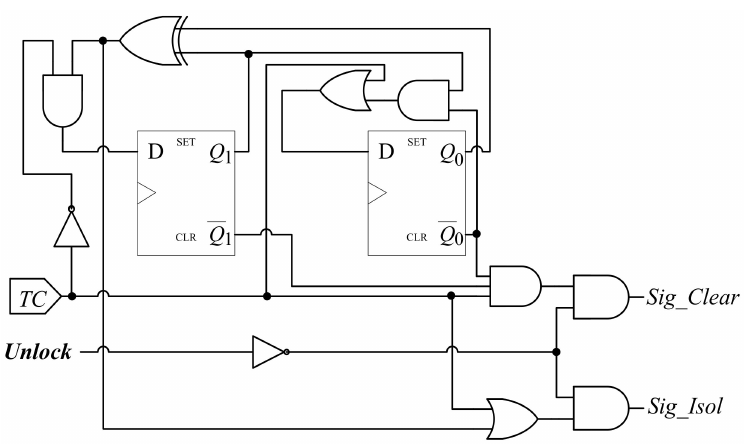
Figure 9. Architecture of improved automatic test control